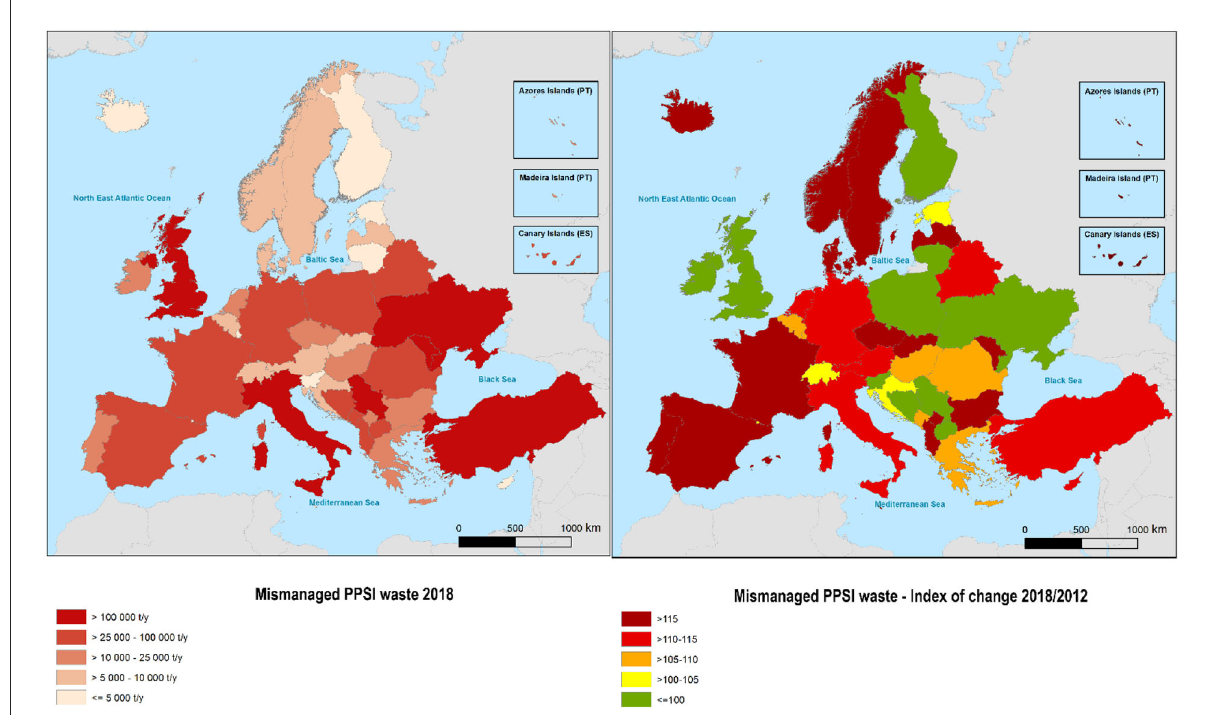
FIGURE6 Total estimated amounts of mismanaged PPSI waste in 2018 (tons per year, t/y) (left) and index of change 2018/2012 (right) in the EU-27 plus Iceland, Liechtenstein, Norway, Switzerland, Turkey, and the UK (estimates for other countries displayed are based on World Bank data).